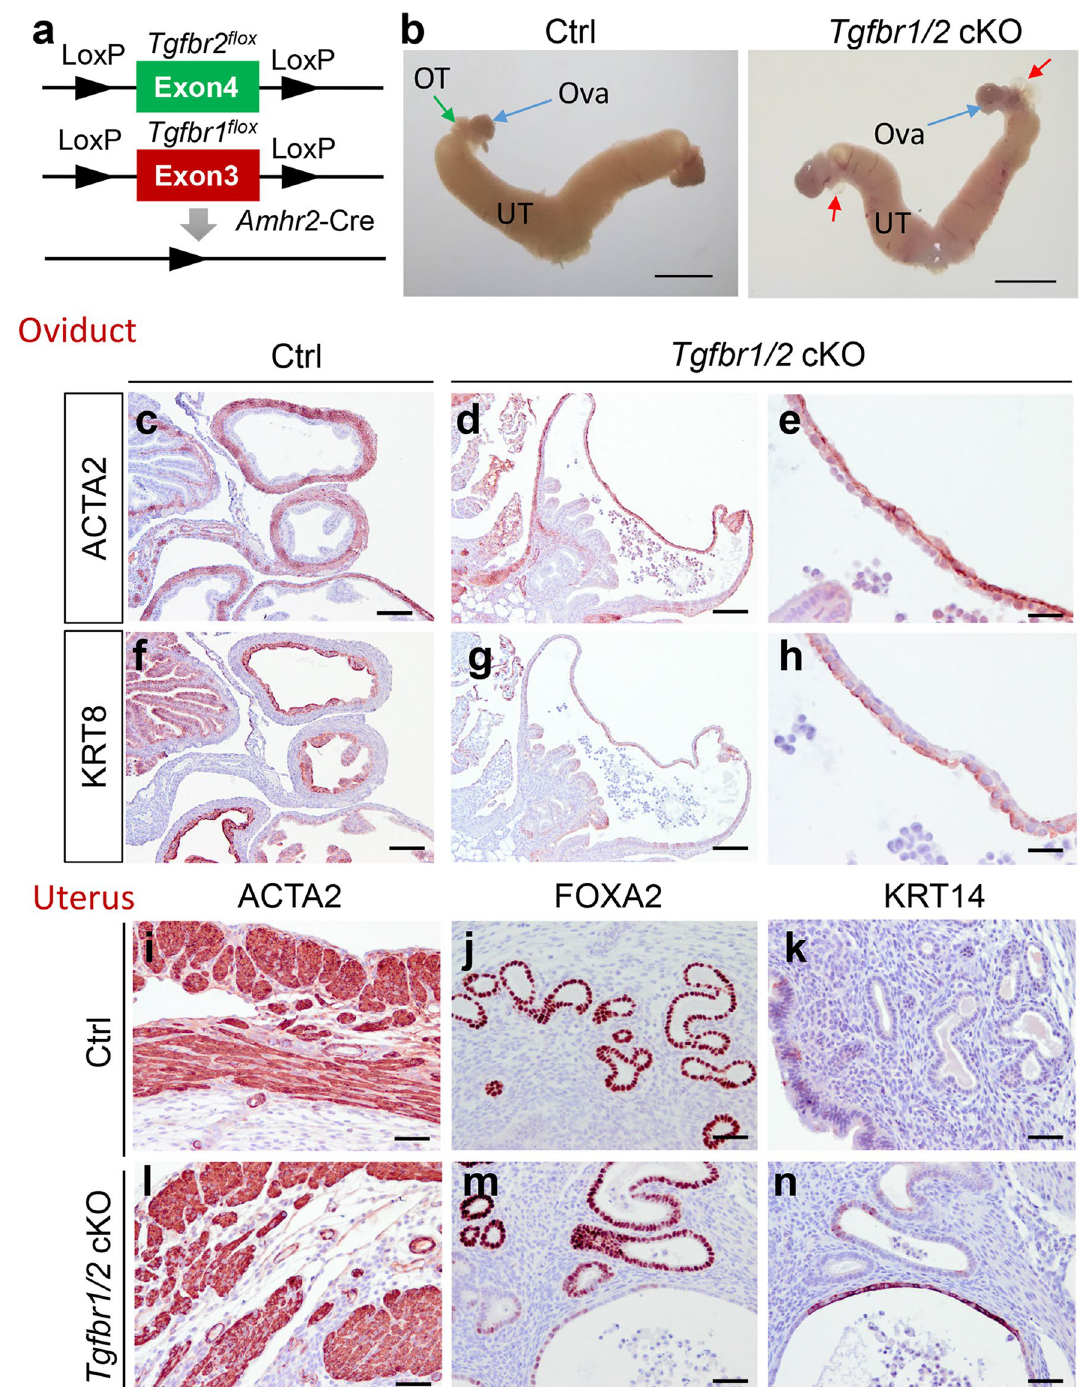
Figure 6. Phenotypic characterization of Tgfbr1/2 cKO. ( a ) Schematic representation of generation of Tgfbr1/2 cKO. ( b ) Gross image of uteri from controls and Tgfbr1/2 cKO at 3 months of age. UT, uterus; OT, oviduct; Ova, ovary. Scale bar = 4 mm. ( c–h ) Localization of ACTA2 and KRT8 in the oviducts of controls and Tgfbr1/2 cKO at 3 months of age. ( e , h ) Are higher magnification images for ( d , g ). ( i–n ) Immunostaining of ACTA2, FOXA2, and KRT14 using uteri from controls and Tgfbr1/2 cKO at 3 months of age. Three independent mice were examined for each genotype. Scale bar equals 25 µm ( e , h ), 50 µm ( i – n ), 100 µm ( c , d , f , g